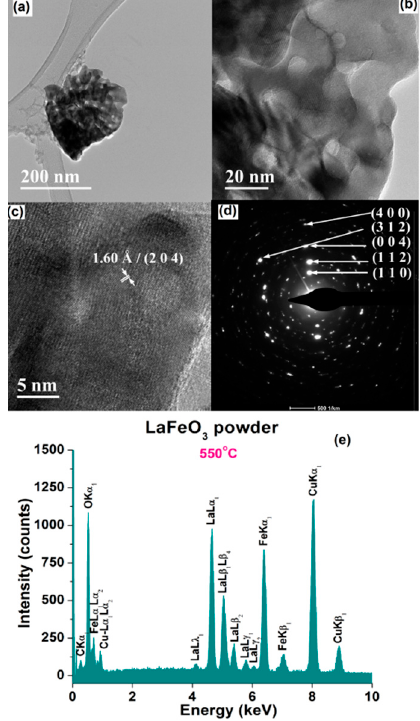
Figure 6. (a), (b) TEM images of various magnifications: (c) HRTEM image, (d) SAED pattern, and (e) EDX spectrum for LaFeO 3 powder calcined at 550 °C.